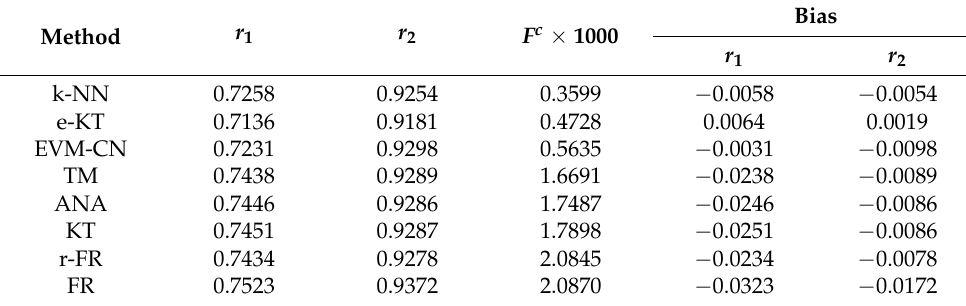
Table 16. Reactivity ratios obtained in the imposed conditions of MC2.